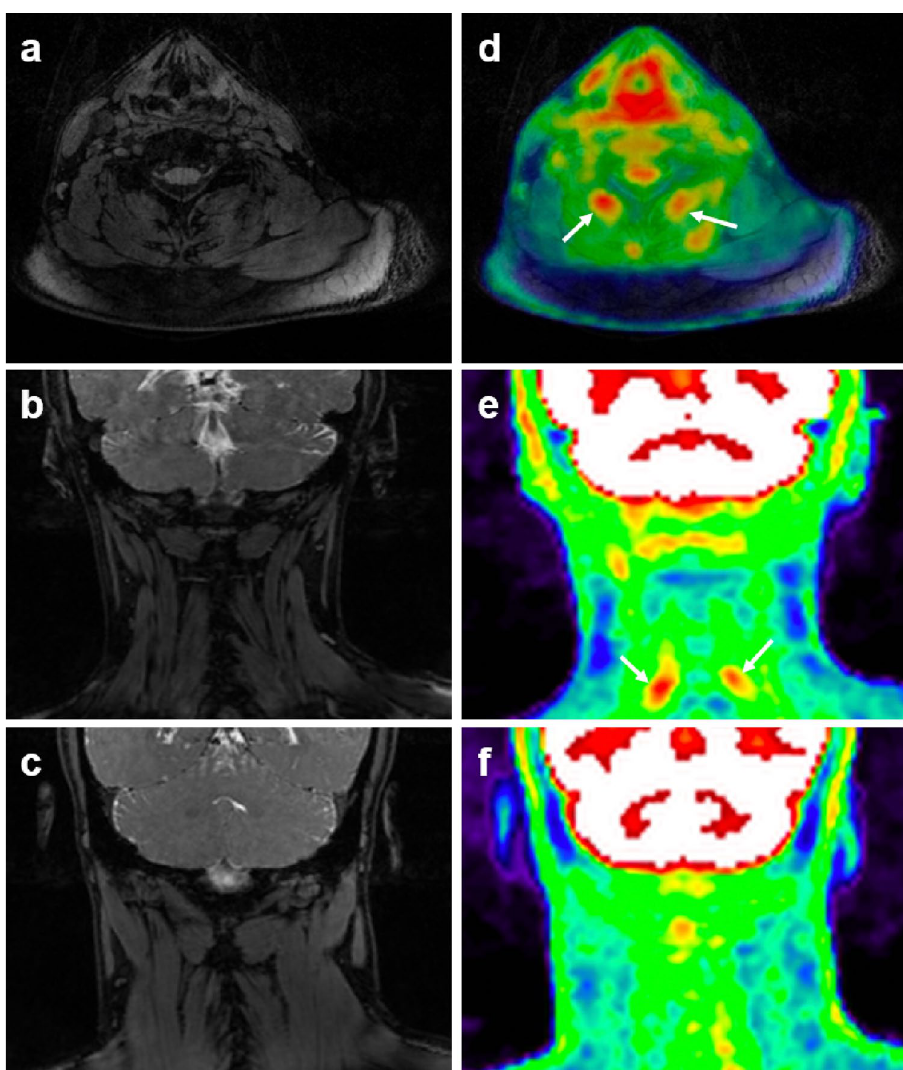
Figure 1. Increased [18F]FDG uptake in cervical paraspinal muscles of patient with suspected cerebrospinal fluid leak . Axial MRI at C6 ( a ) appears normal, while the corresponding axial PET/MRI ( d ) shows increased [18F]FDG uptake in paraspinal muscles (arrows, mean SUV max = 2.24) of a CSF-leak patient presenting with head pain. The same pattern is also shown in coronal MRI ( b ) and PET/MRI ( e ). The corresponding coronal MRI and PET/MRI images from a healthy control subject is displayed in ( c ) and ( f ), respectively. No abnormal focal uptake of [18F]FDG as high as those in the patient case is observed in the asymptomatic subject (mean SUV max =